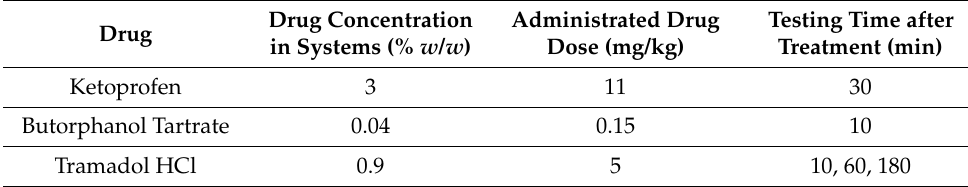
Table 2. Experimental parameters in testing analgesia following treatment with drugs in NVS, nasal water solution (WS), nasal non-vesicular system (NV) and oral preparation (PO) in animal model. Drug Concentration Administrated Drug Testing Time after Drug in Systems (% w / w ) Dose (mg/kg) Treatment (min) Ketoprofen 3 11 30 Butorphanol Tartrate 0.04 0.15 10 Tramadol HCl 0.9 5 10, 60,